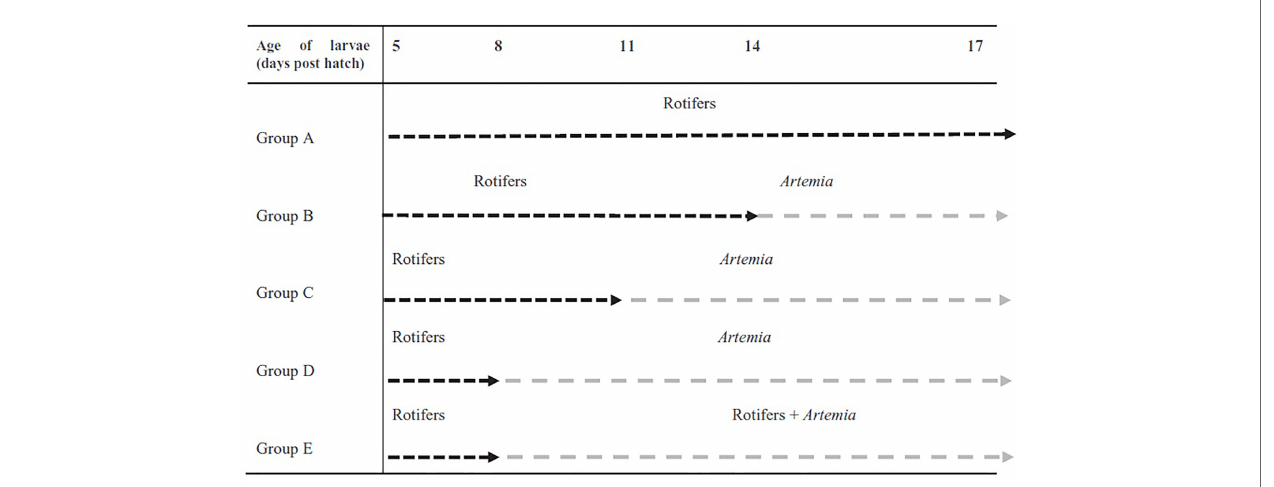
FIGURE 1 | The applied feeding regimes for pikeperch larvae throughout the experiment (Imentai et al.,